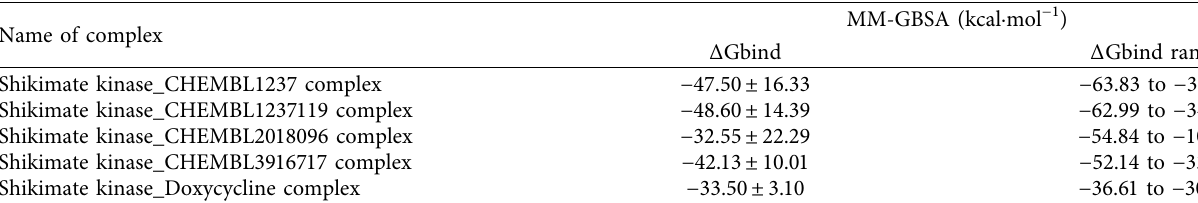
Figure 7: Diagram of protein-ligand complex chart of (a) Shikimate kinase_CHEMBL1237, (b) Shikimate kinase_CHEMBL1237119, (c) Shikimate kinase_CHEMBL2018096, (d) Shikimate kinase_CHEMBL3916717, and (e) Shikimate kinase_Doxycycline complexes. Table 5: Postsimulation binding-free calculation